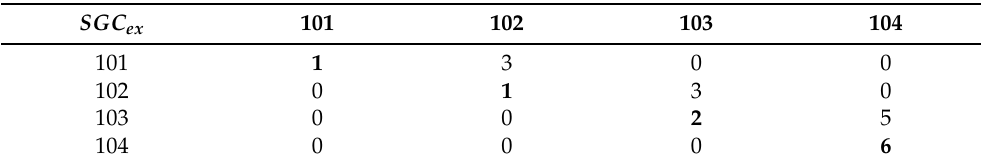
Table 3. Table representation of, SGC ex 2 , including external unique identifiers as row and column